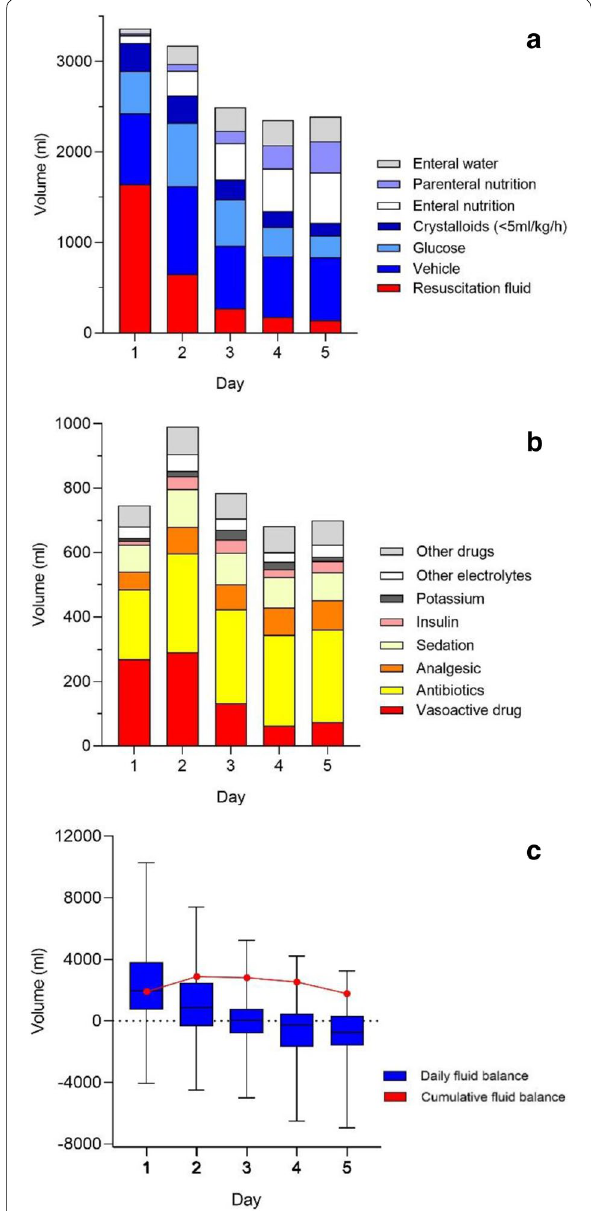
Fig. 1 a Median daily volume and type of fluids. Data for type of fluids each day are presented as fraction of total daily volume. Please note that sum of the median daily volume does not equal sums of median non‑resuscitation and resuscitation fluids over the whole observation period because of the skewed distribution of the data. N number of patients. b Median daily volume and type of vehicle. Data for type of vehicle each day are presented as fraction of total daily volume. N number of patients. c Daily and cumulative fluid